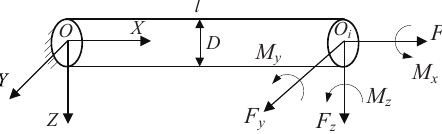
Figure 4. Model of a round beam flexure with specified